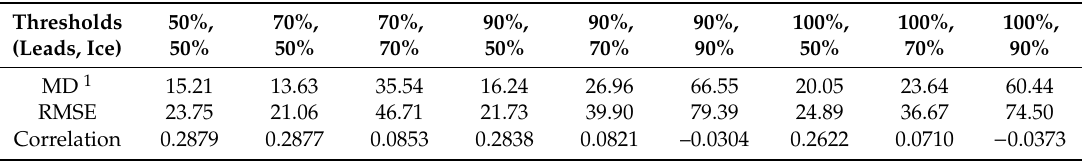
Table 4. Sea ice freeboard results from application of TFMRA with di ff erent retracking thresholds relative to freeboard data from OIB March 2014 data. Unit: